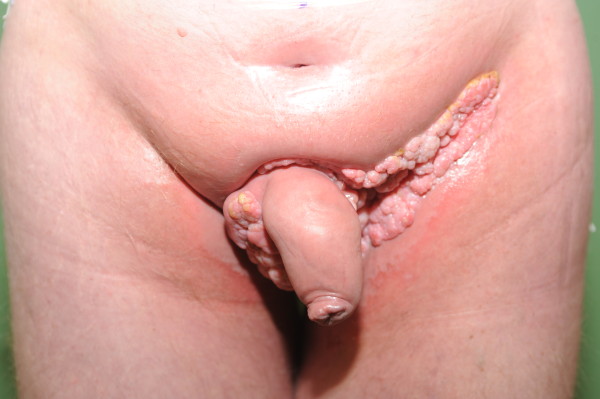
Tumor after therapy.